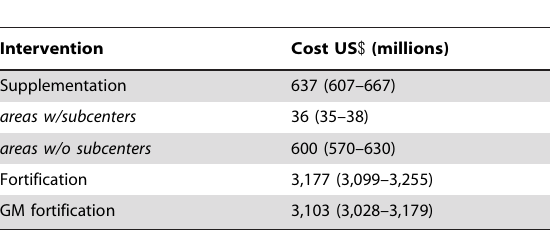
Table 3. Cost of intervention